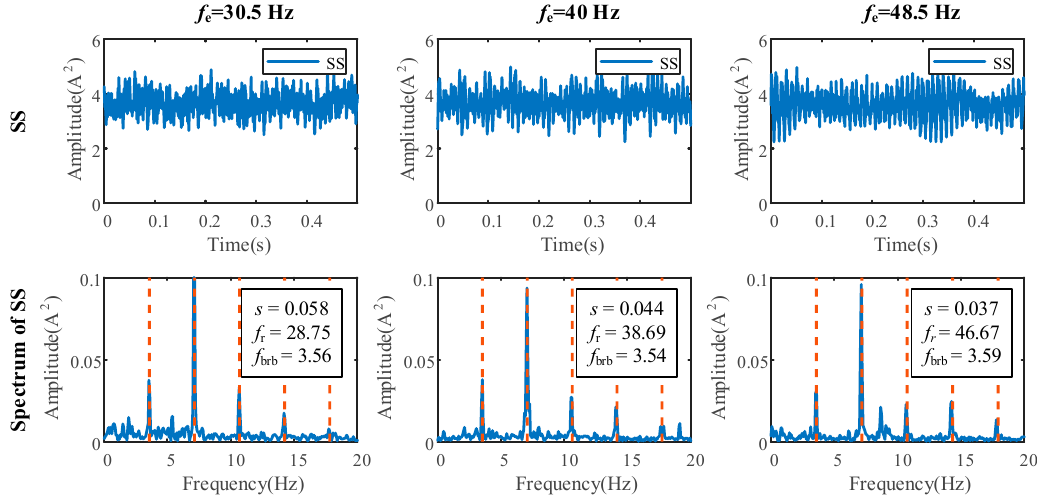
Figure 7. The SS signals and their spectra of the faulty motor under different rotation speeds.